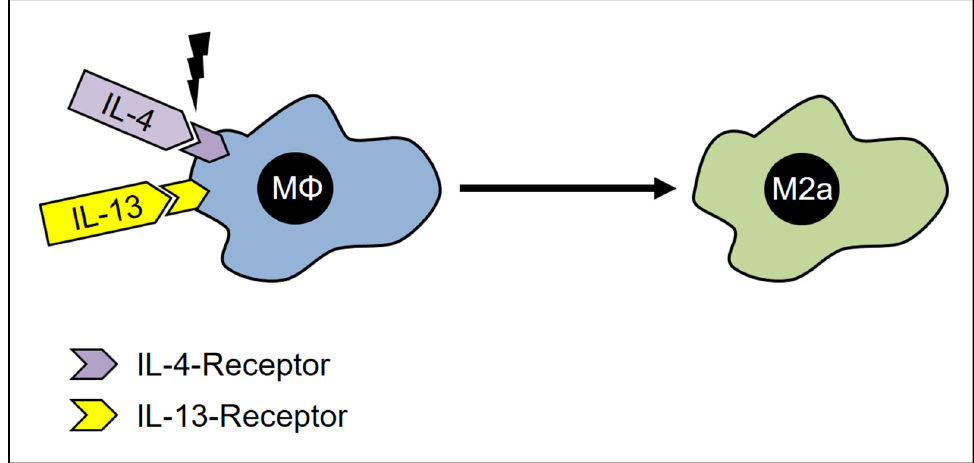
Figure 5. The activation of M2a-Macrophages. In the presence of IL-4- and IL-13- receptor ligands, the macrophages adopt the M2a phenotype, which is characterized by the expression of INF- β and TNF- α –receptors. Furthermore, these cells are now able to synthesize TNF- α and INF- β and thus undergo self-activation.